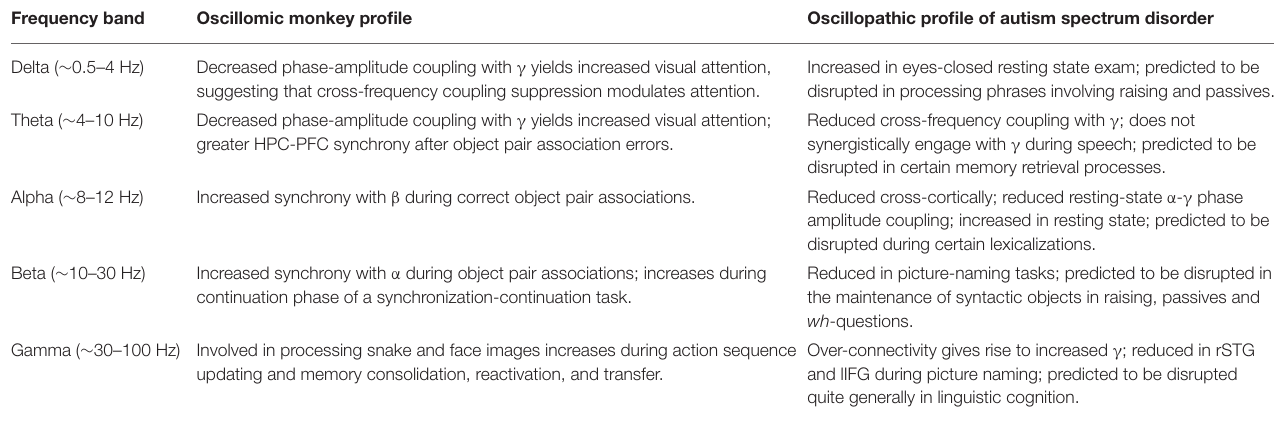
TABLE 3 | Summary of the patterns of rhythmicity observed in wild primates and the observed oscillomic differences in ASD compared to TD subjects. Frequency